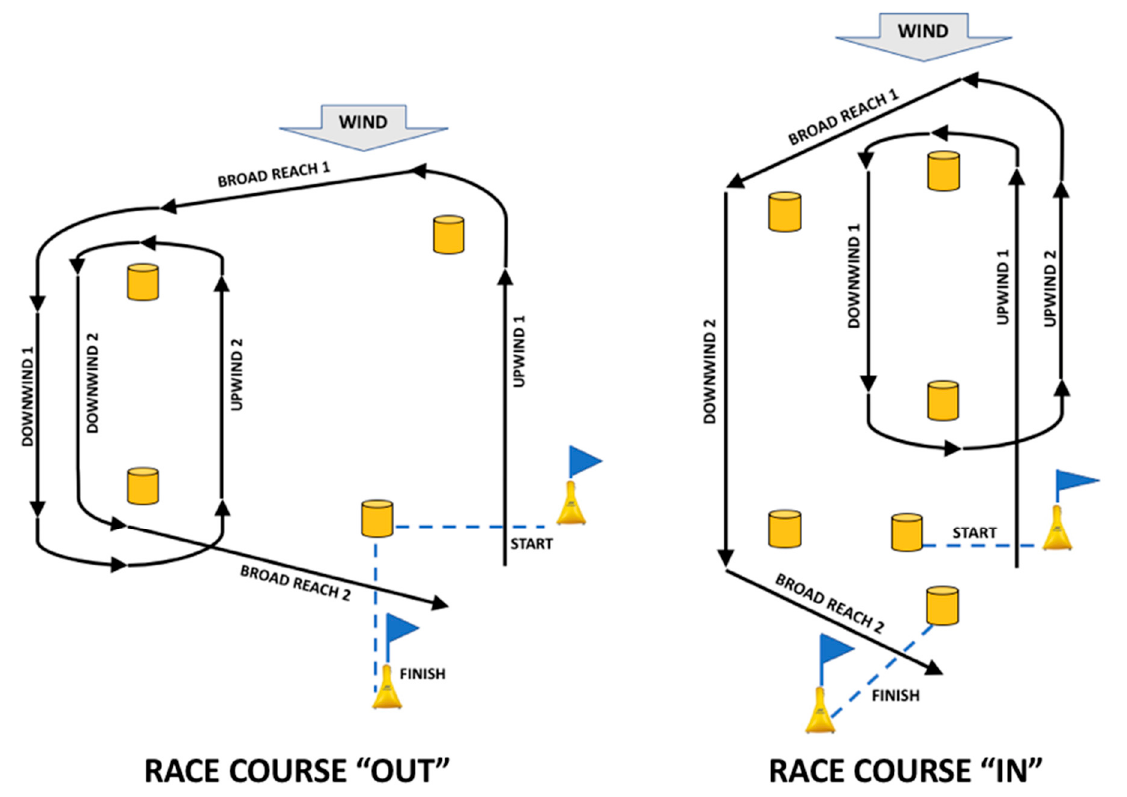
Figure 1. Regatta race courses.